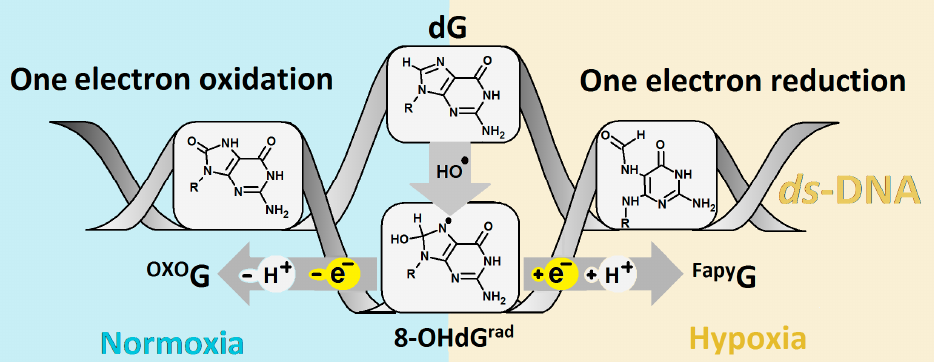
Figure 1. Graphical representation of OXO dG and Fapy dG formation in ds-DNA as a product of hydroxyl radical action, depending on cellular condition.